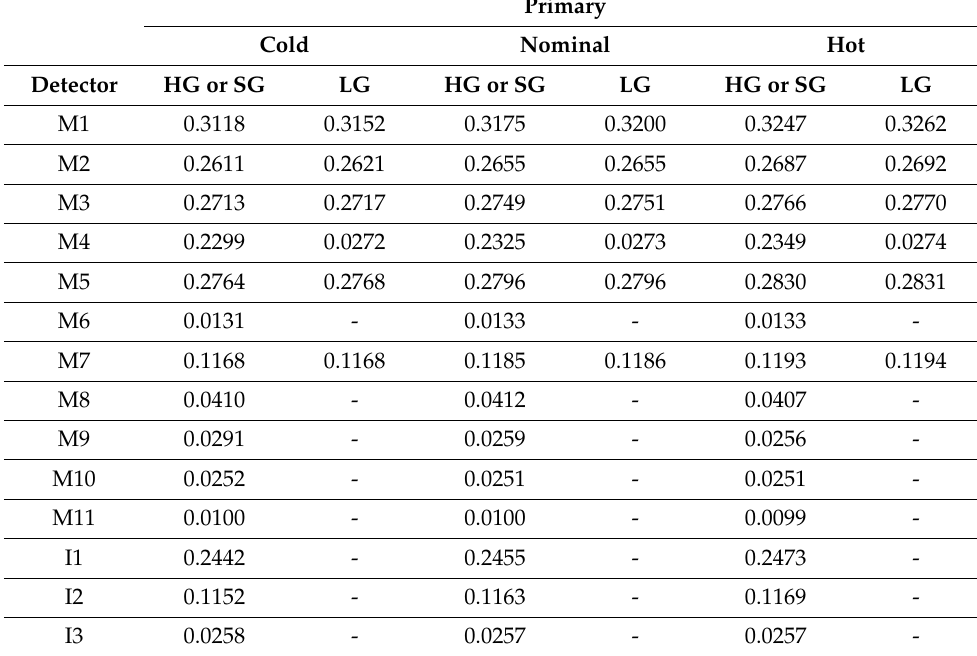
Table 5. JPSS-2 VIIRS c 1 calibration coefficient for each RSB gain stage and TVAC plateau at the primary electronics setting. The left, middle, and right sections are for cold, nominal and hot plateaus,